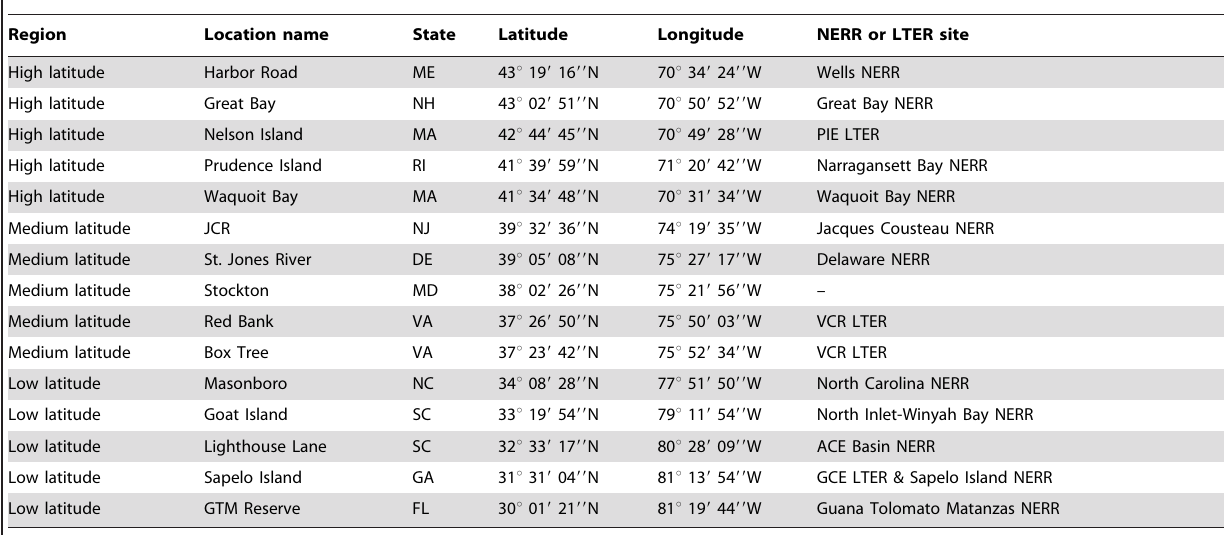
Table 1. Study locations on the Atlantic Coast of the United